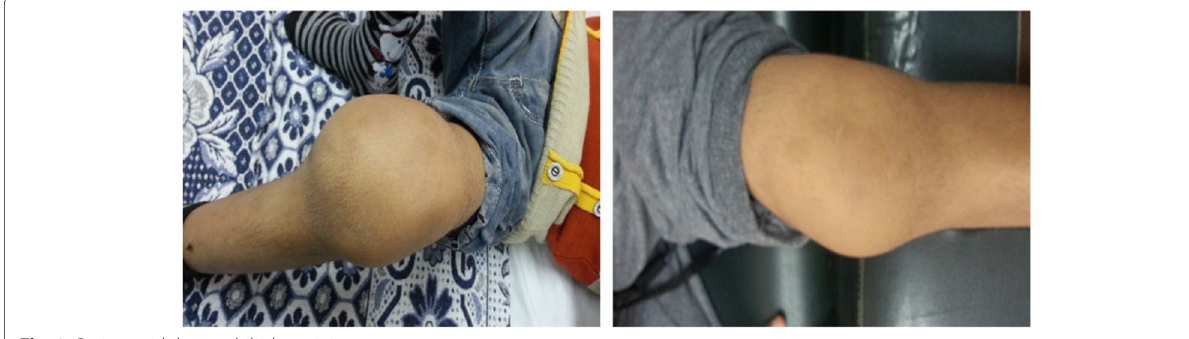
Fig. 2 Patient with hemophilic knee